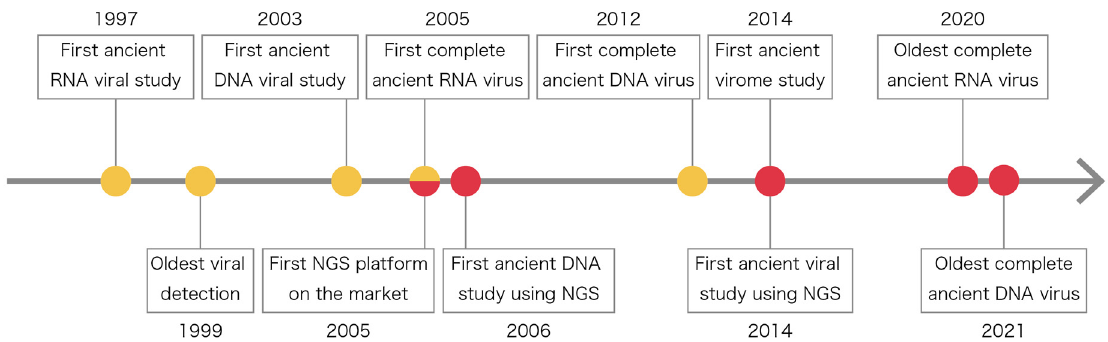
Figure 1. History of ancient viral studies. Yellow and pink dots indicate studies or events related to polymerase chain reaction (PCR) and next-generation sequencing (NGS) techniques, respectively.